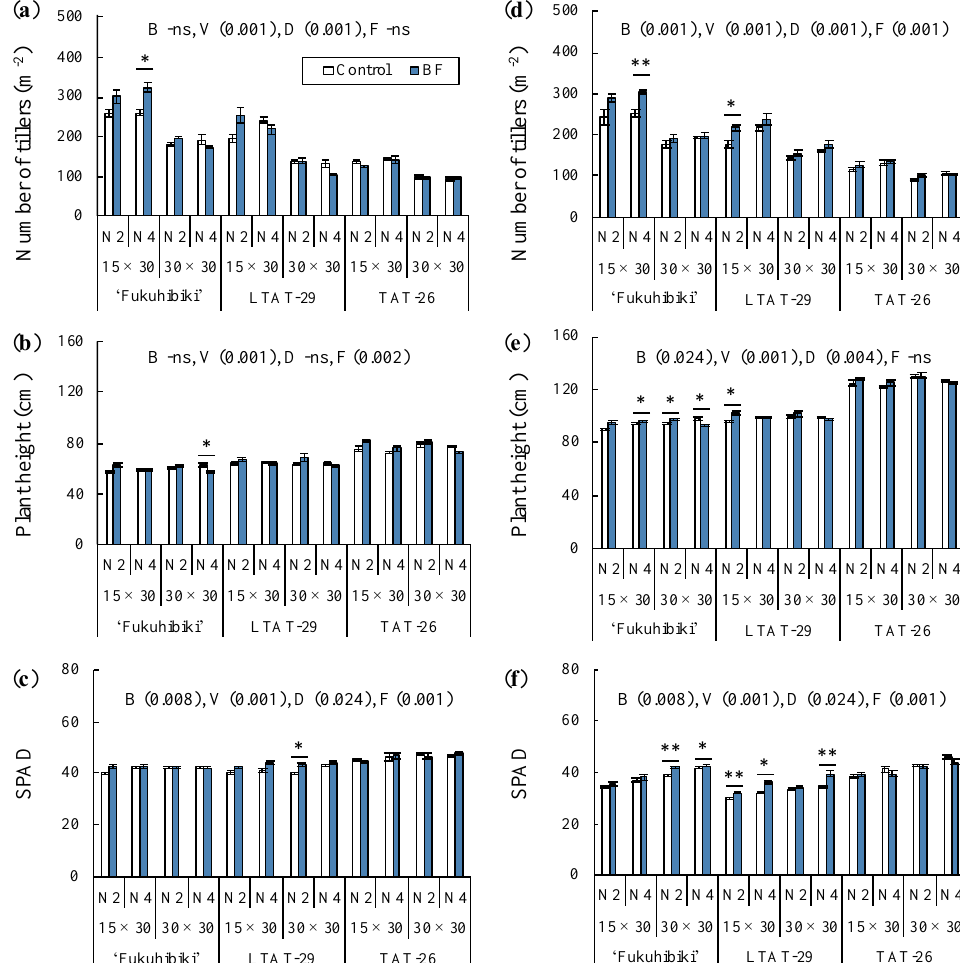
Figure 3. Summary of surveys on the paddy field. ( a ) The number of tillers, ( b ) the plant height, and ( c ) SPAD value measured at 8 weeks after transplanting. ( d ) The number of tillers, ( e ) the plant height, and ( f ) SPAD value measured at 13 weeks after transplanting. B: Biofertilizer, V: Variety, D: Distance, F: Fertilization. Each number inside of parenthesis is p value (ANOVA). * and ** indicate significant differences at p ≤ 0.05 and 0.01 levels between control and biofertilizer application in each treatment, respectively ( t- test, two-sided). Error bar indicates standard deviation (SD). n = 3. At the late vegetative growth stage of rice (i.e., 91 and 92 days after transplanting),